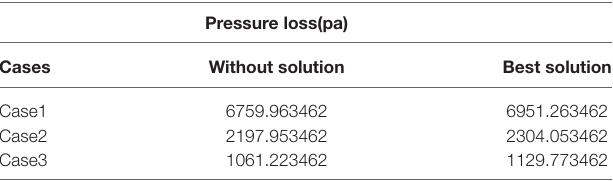
TABLE 2 | The pressure loss for cases from the heat